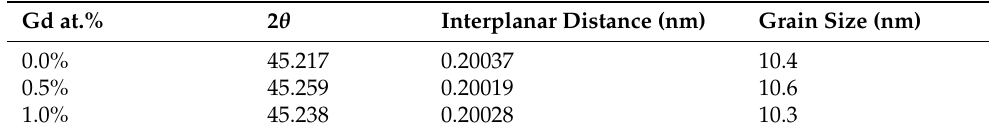
Figure 1. X-ray diffraction data before and after annealing. ( a ): as-casted alloy; ( b ): annealed alloy. Table 2. Crystallization peaks of samples.